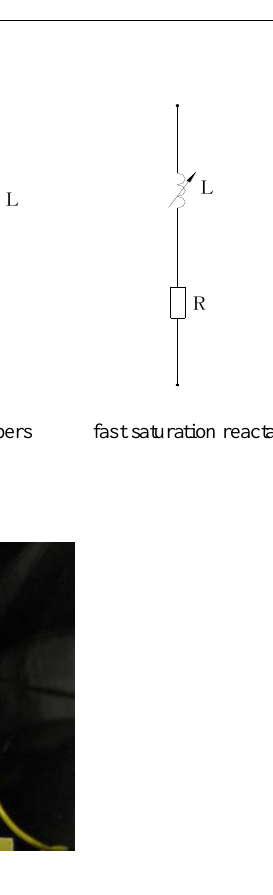
Figure 12. Fast saturation damper.